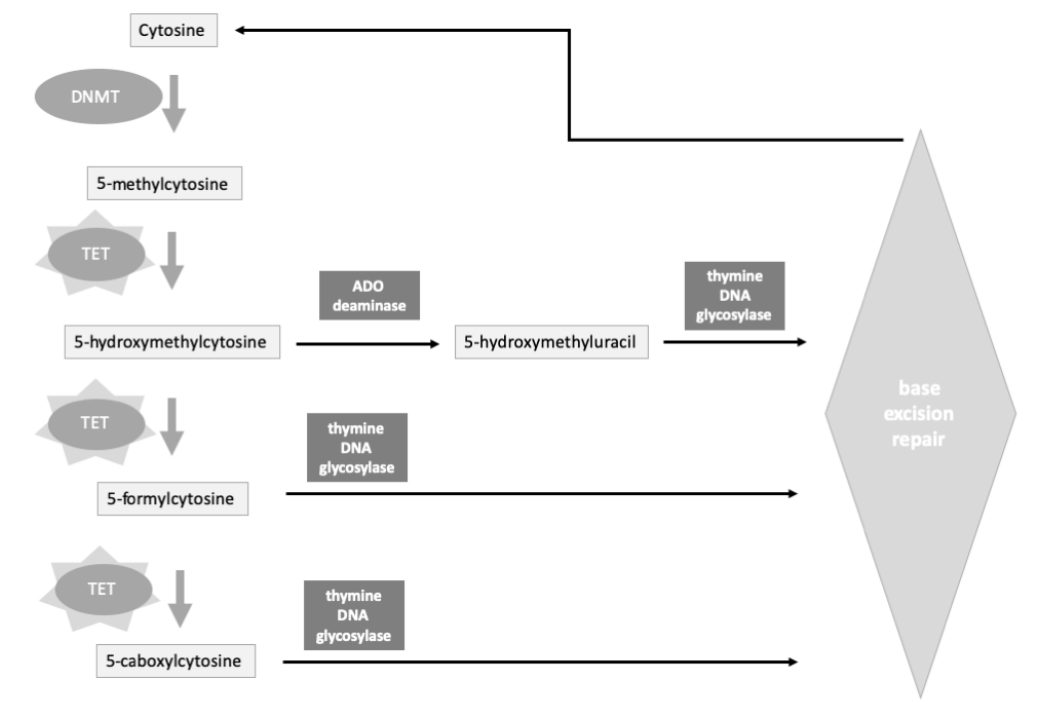
Figure 4. Schematic representation of the cytosine demethylation pathways and the role of the ten-eleven translocation (TET) enzymes.TET enzymes (star background) initiate the processing of 5-methylcitosine, by forming various derivatives, of the initial methylated cytosine precursor, in sequence (5-hydroxymethylcytosine, 5-formylcytosine, 5-carboxylcytosine). These are in turn further processed by the indicated enzyme systems, finally. See also [60,61] ADO, adenosine; DNMT, DNA methyltransferase; TET ten-eleven translocation.